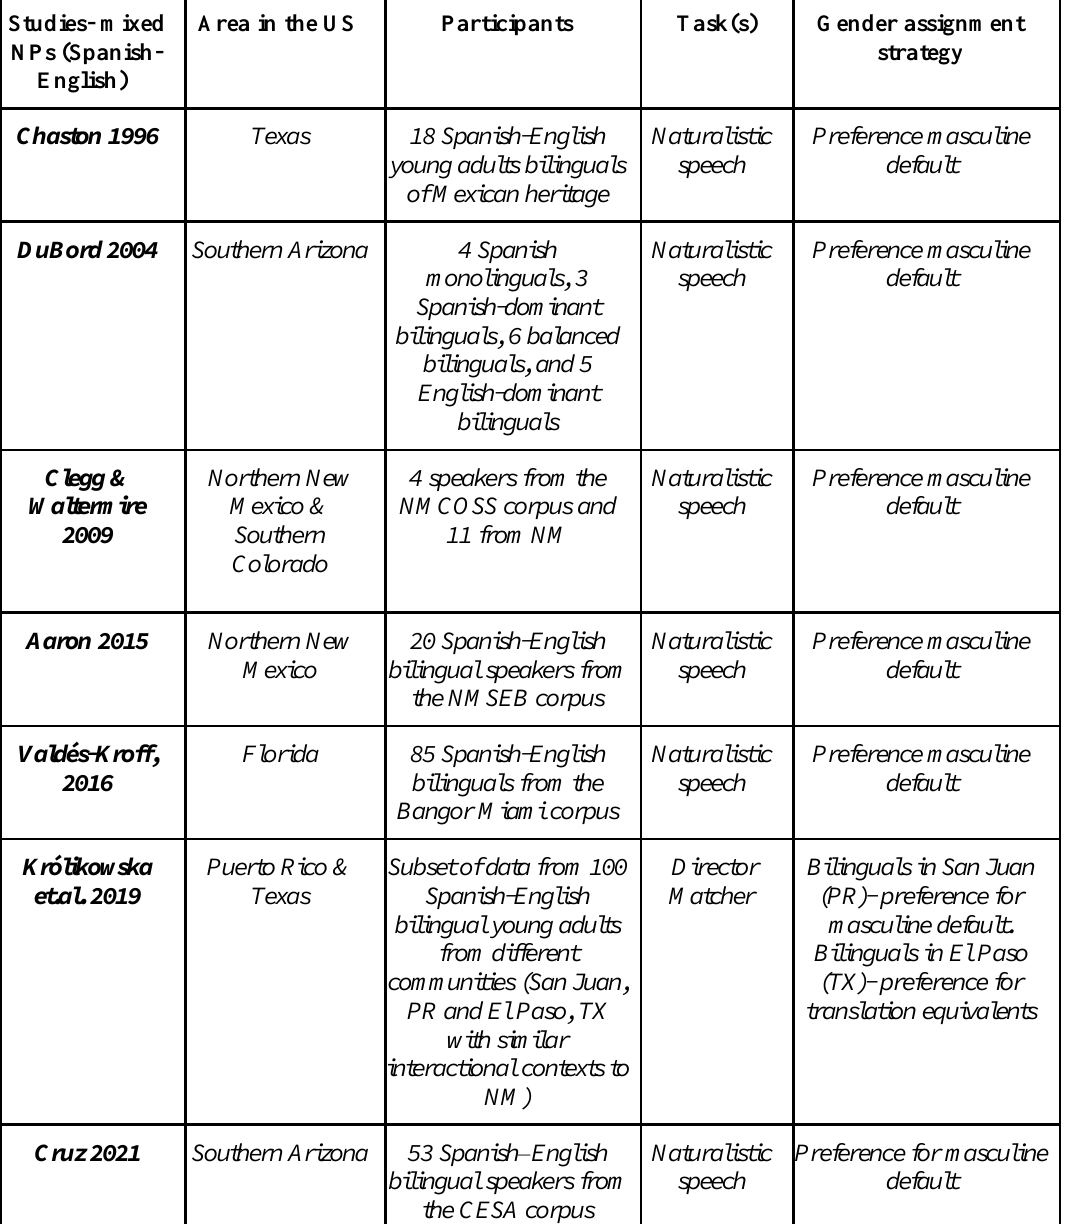
Table 1. Overview of studies on Spanish-English mixed NPs in the US Studies-